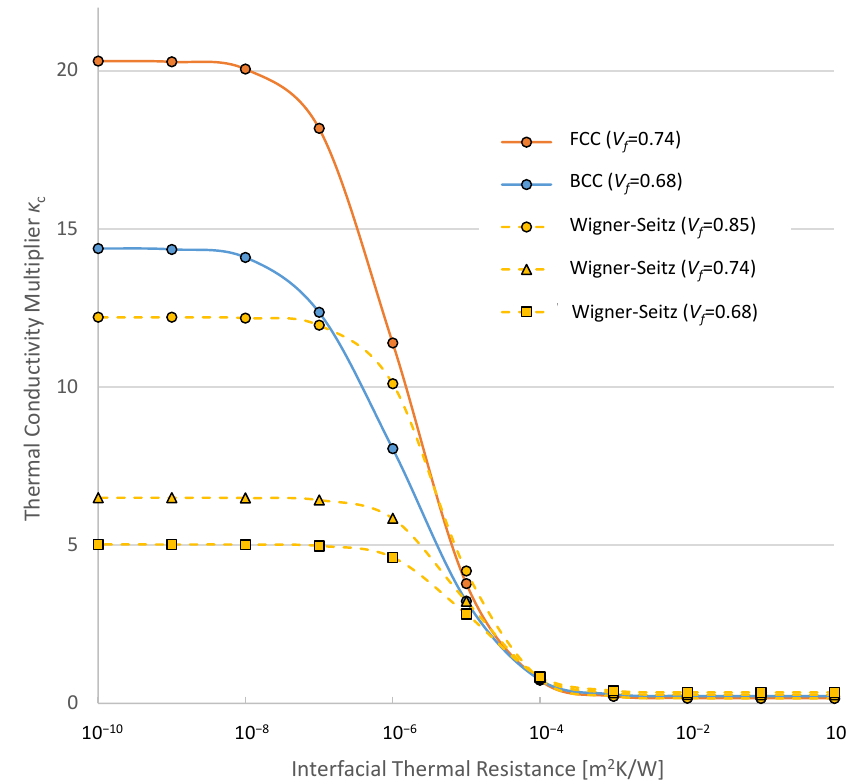
Figure 18. Effective thermal conductivities with different interfacial thermal resistances.